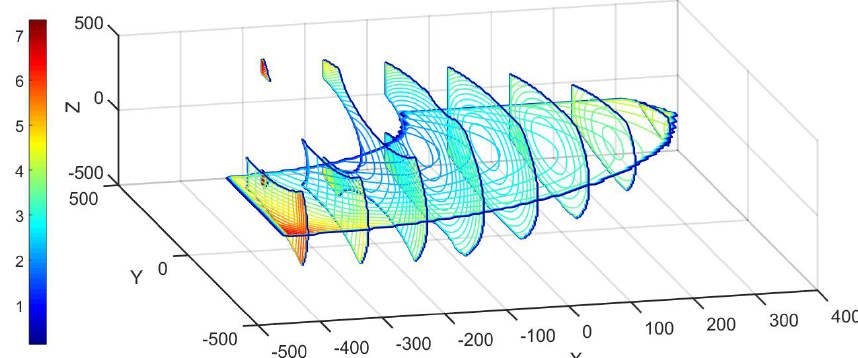
Figure 11. Condition numbers of the Jacobian matrices